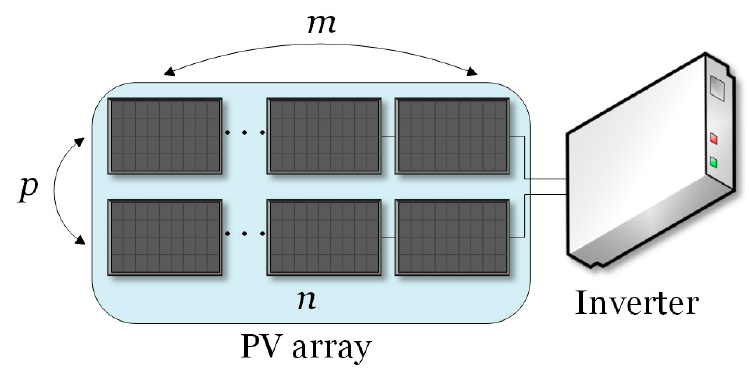
Figure 5. Clarification of PV array topology variables.